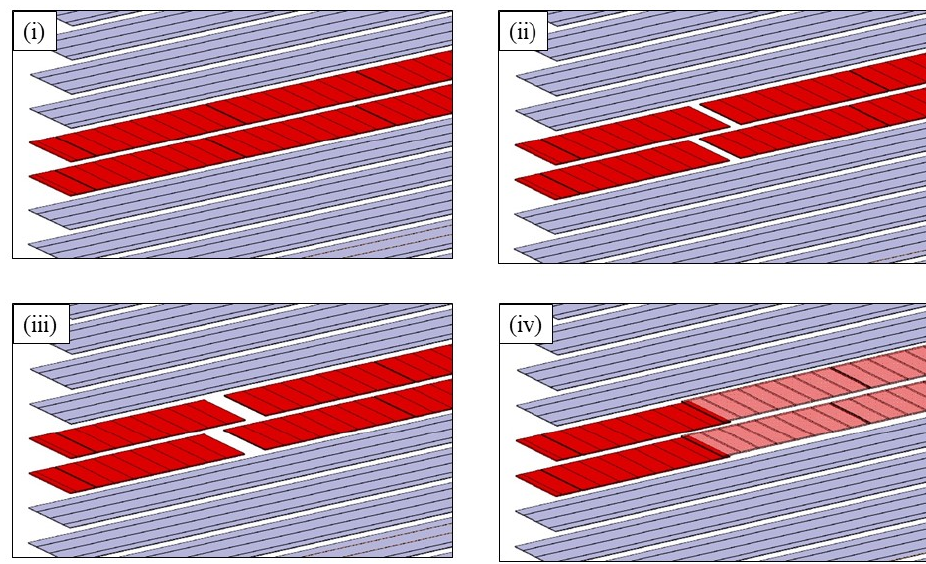
Figure 2. Specimens layups [90°/0°7/90°2/0°7/90°] showing embedded defects in the centre plies of the laminate. Plies oriented at 0° are shown in grey and plies oriented at 90° are shown in red. ( i ) Gap 0.5 mm; ( ii ) Gap 3.175 mm, ( iii ) Gap 6.35 mm, ( iv ) Overlap 3.175 mm.